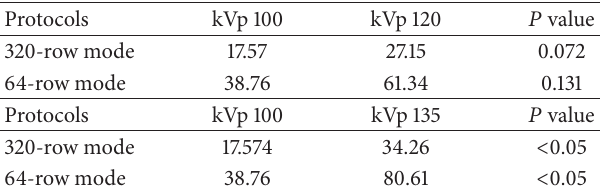
Table 4: The effect of tube voltage variation on ARD (mGy) for dose modulation protocol at both 64-row and 320-row modes.